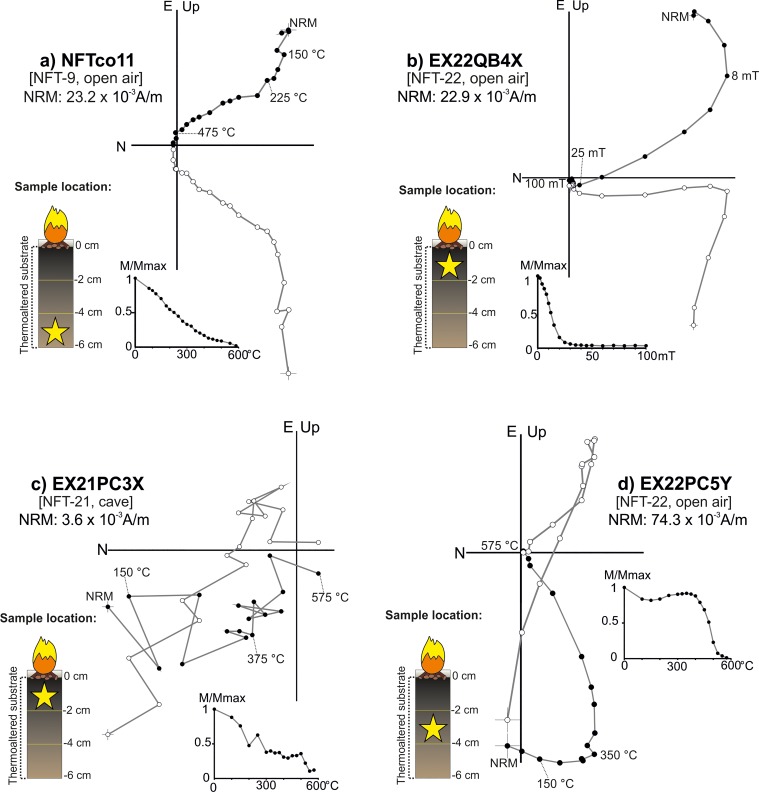
Representative orthogonal NRM thermal and alternating field demagnetizations plots of samples showing anomalous NRM behaviour.Stratigraphic location of each sample with respect to the surface is indicated for each panel. Symbols as in Fig 7.